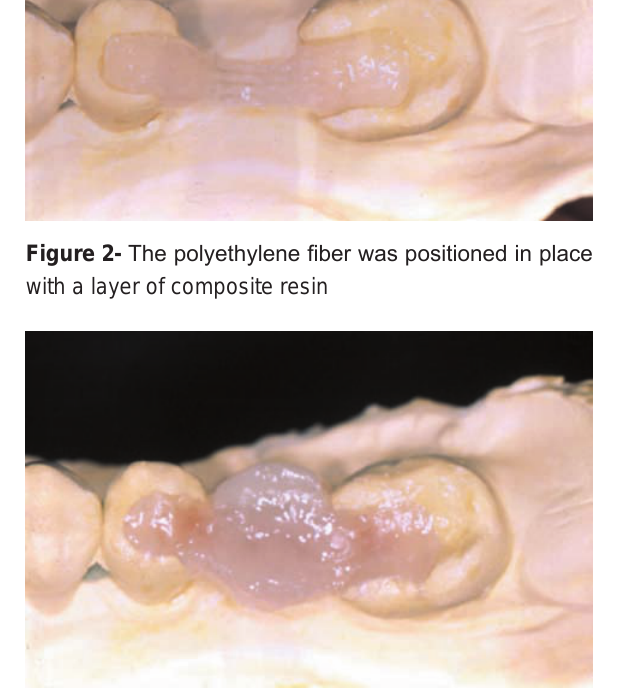
Figure 3- The fixed partial denture is completed with additional composite layers